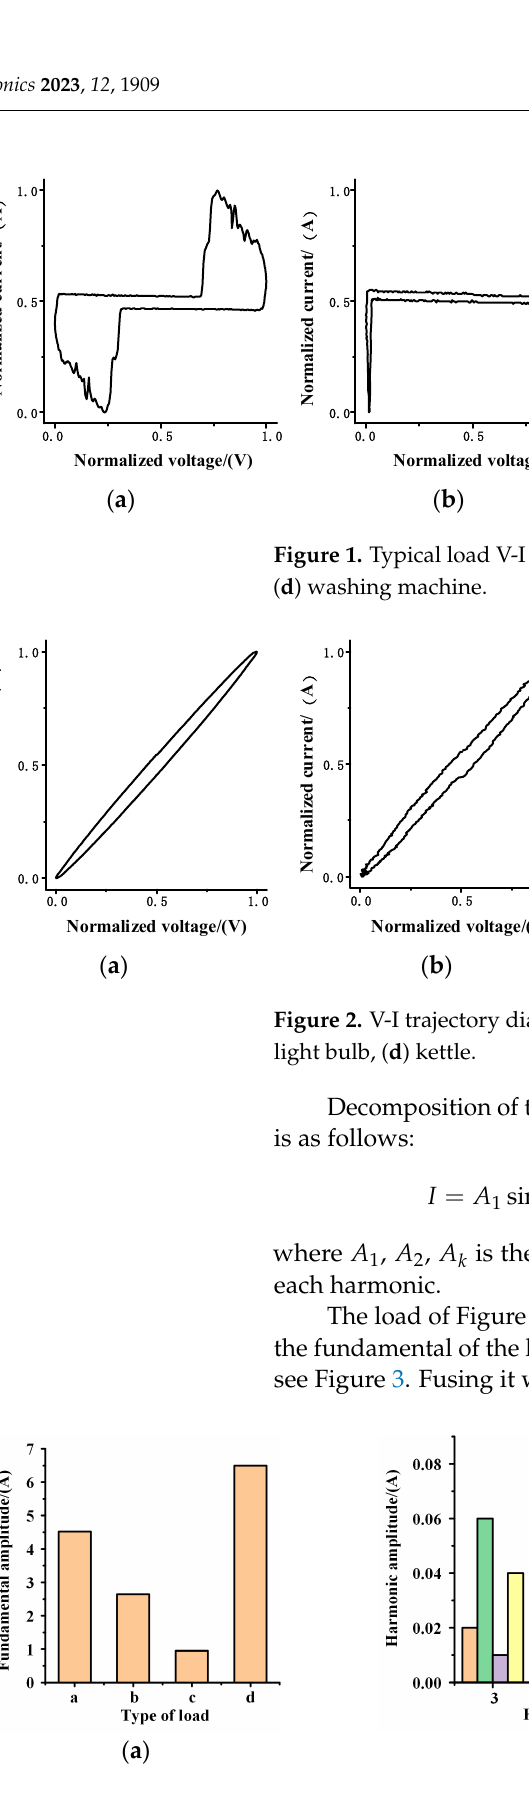
Figure 3. ( a ) Base wave amplitude, ( b ) odd harmonic amplitudes, ( c ) odd harmonic phase. Harmonic amplitude and phase are numerically large and fusing them with V-I traces requires data processing for voltage, current, and amplitude phase. To normalize the selected data: